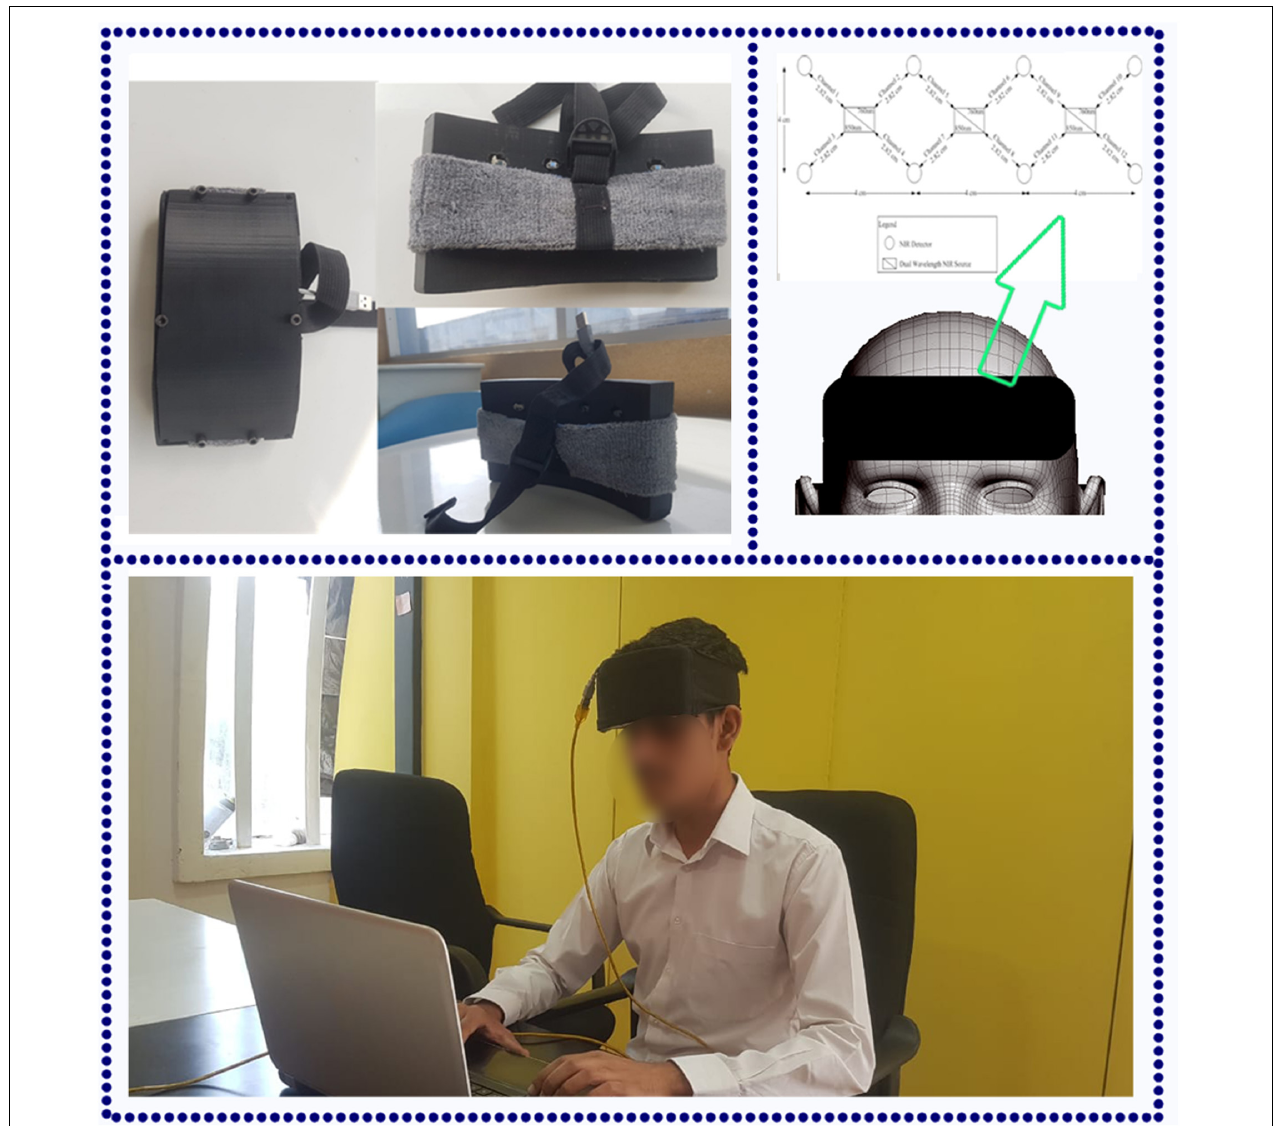
FIGURE 2 | The functional near-infrared spectroscopy (fNIRS) (P-fNIRSSyst) system placed to measure participants’ prefrontal cortex (PFC) activity. Optodes are placed according to the standard 10–20 system.